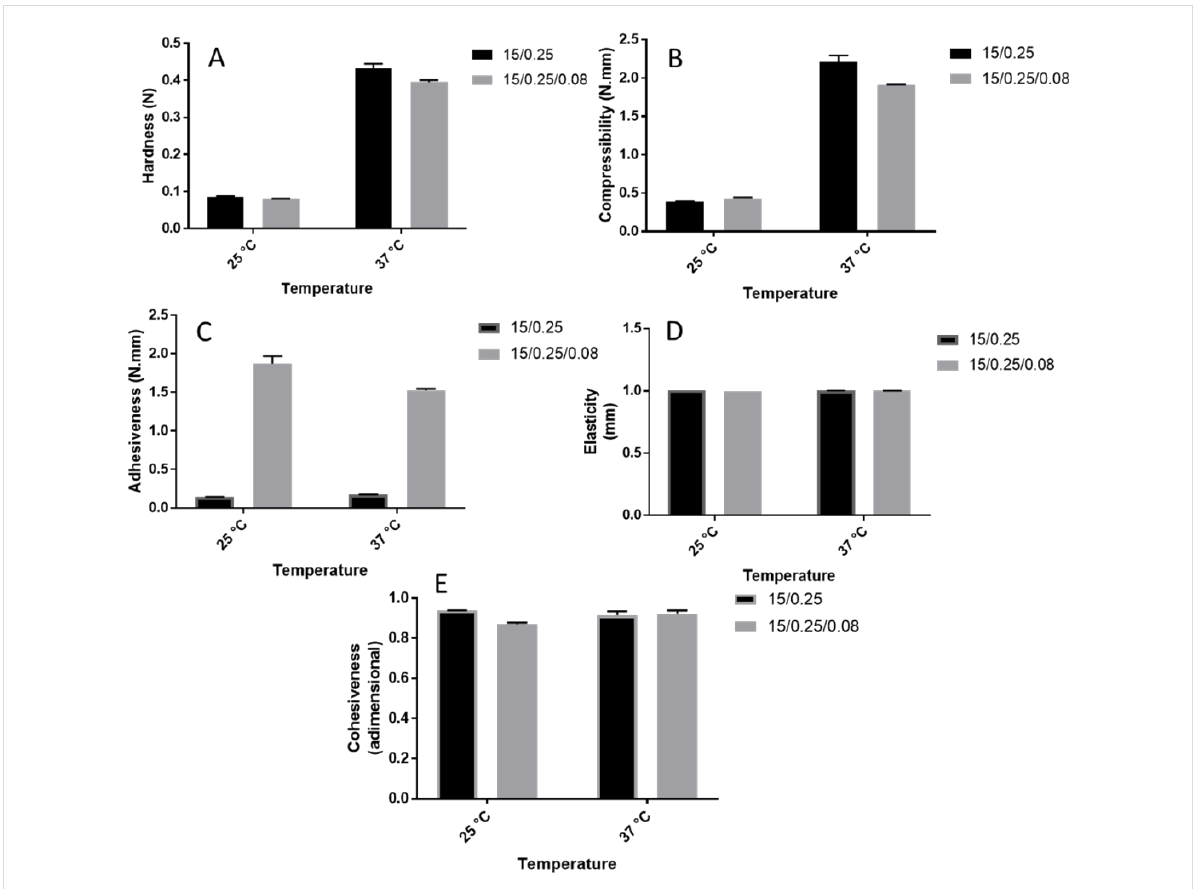
Figure 8: Textural properties of the systems containing P407, C974P and CUR, investigated at 25 and 37 °C: (A) hardness, (B) compressibility, (C) adhesiveness, (D) elasticity and (E) cohesiveness. Each value represents at least three